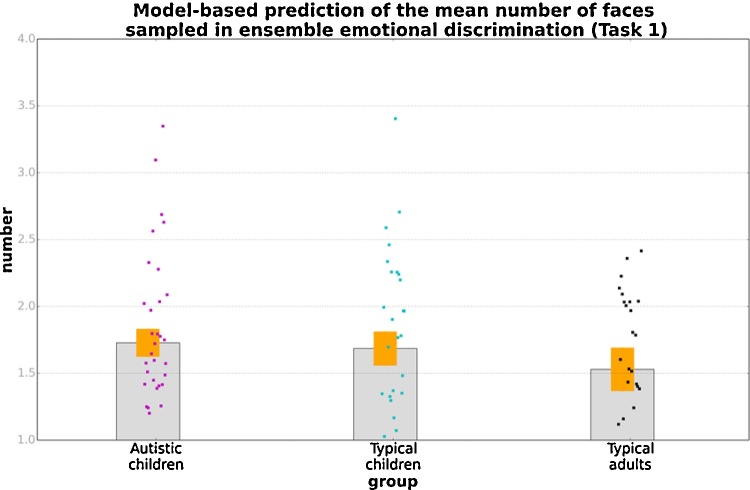
Predicted number of samples for the three groups of participants in the ensemble emotion discrimination task. Orange bands correspond to ±1 SEM, while points superimposed on bars show individual variability.